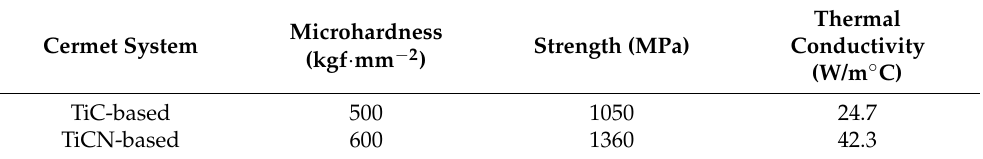
Table 2. Comparison of properties of TiC and